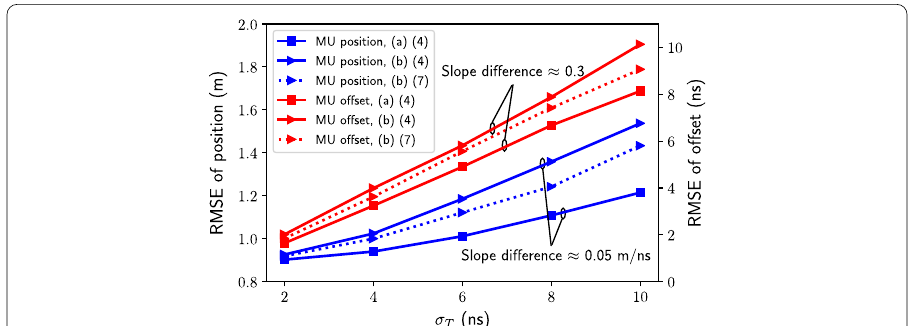
Fig. 13 Impact of hybrid synchronization on MU joint sync&loc. (a)/(b) denotes the algorithm used for network synchronization (Sect. 4.1). The numbers in the legend denote the number of iterations each algorithm